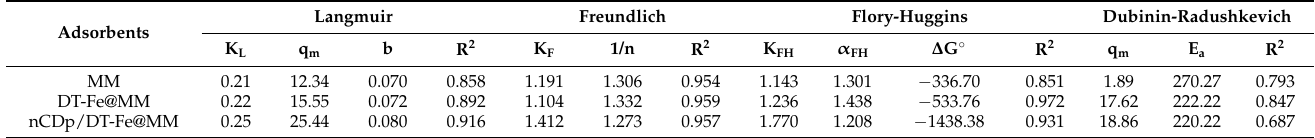
Table 2. Isotherm parameters for adsorption of BPA on functionalized